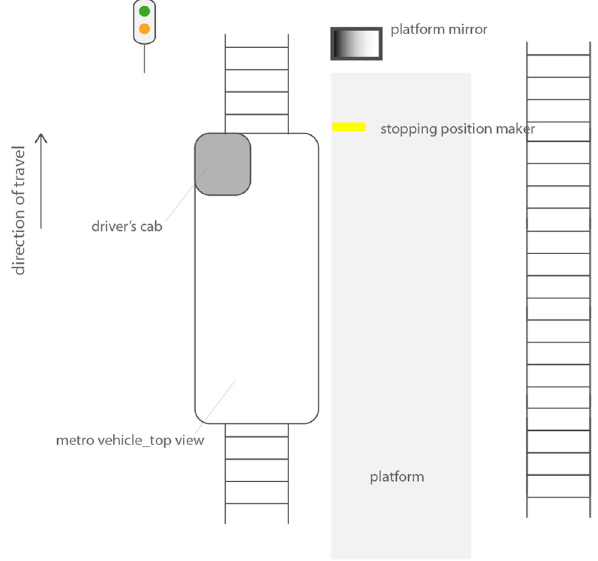
Fig. 2 Typical Type 1 design